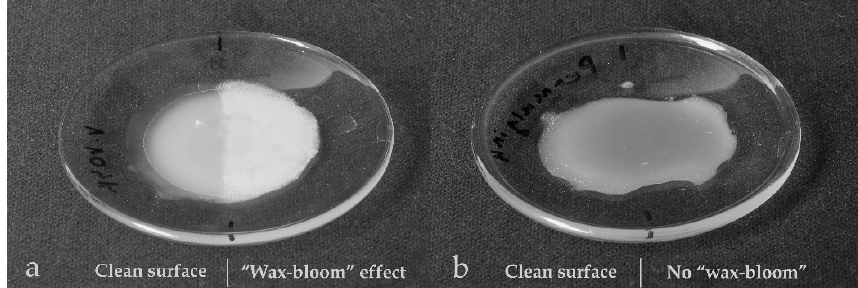
Figure 15. Comparison of the samples in terms of their resistance to the “wax bloom” phenomenon at 18 °C. ( a ): beeswax sample, ( b ): pigmented Permulgin 3274 sample. The right half of each sample was impressed with fingers. In the case of beeswax, this half is covered by the whitish efflorescence.